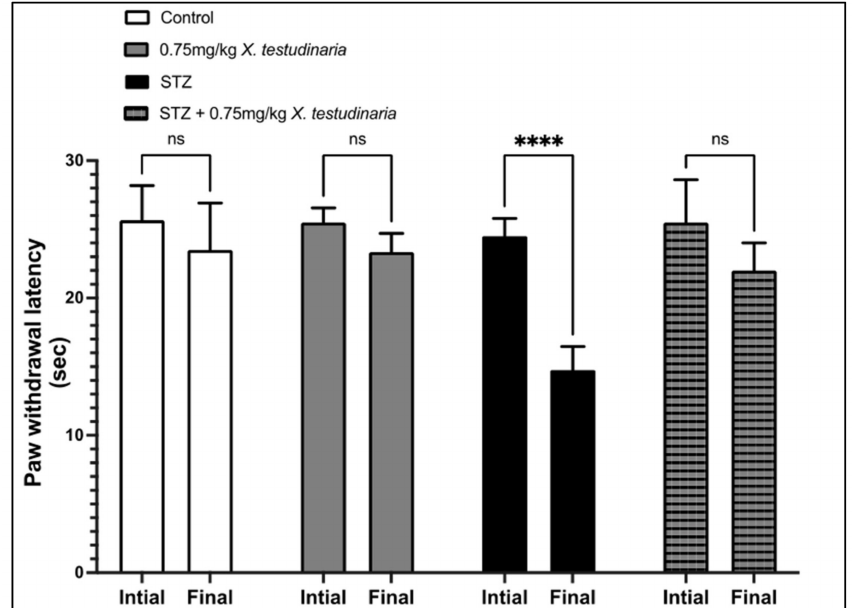
Figure 3. Paw withdrawal latency to hot stimuli in streptozotocin (STZ)-induced diabetic mice. Data are presented as mean ± SD for the mice (n = 6) in each group. Statistical analysis was carried out using one-way ANOVA followed by Tukey post hoc test. ****: statistical significance from the corresponding initial reading was set at p < 0.001. ns: